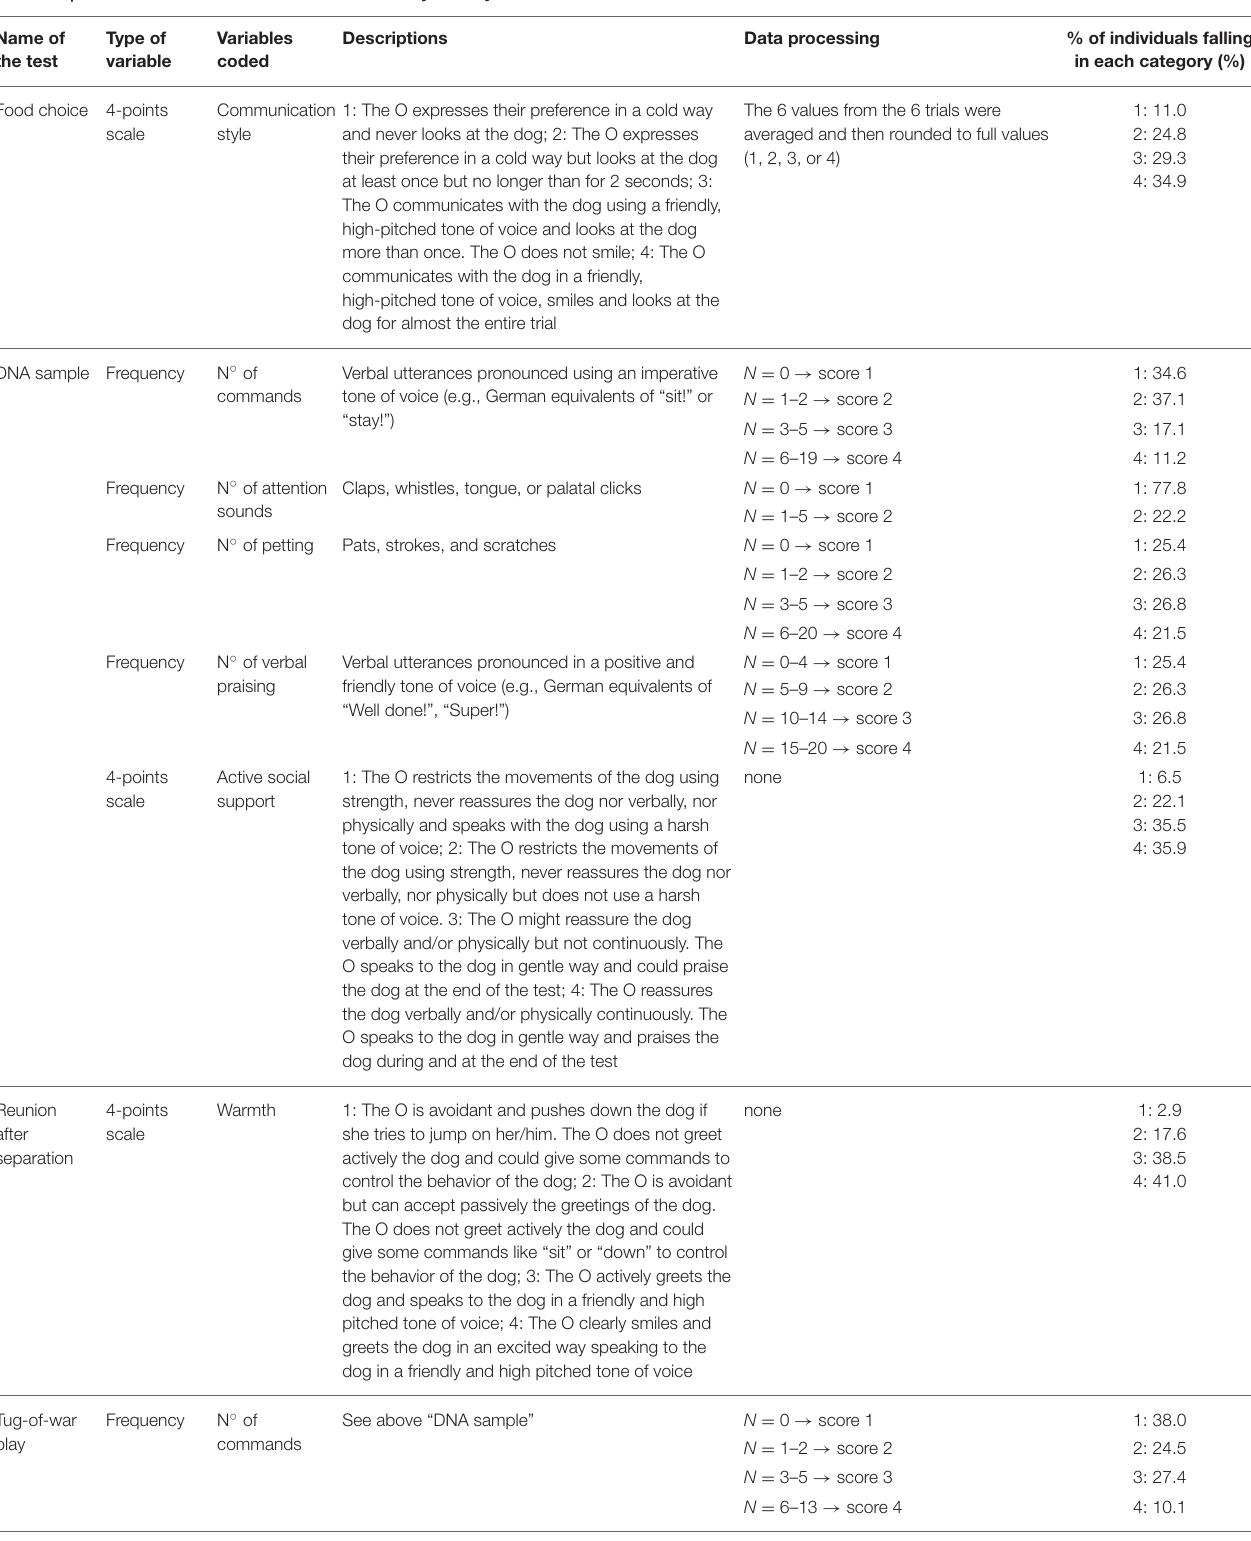
TABLE 1 | Tests included in the owner interaction style analysis and the variables coded in each. Name of the